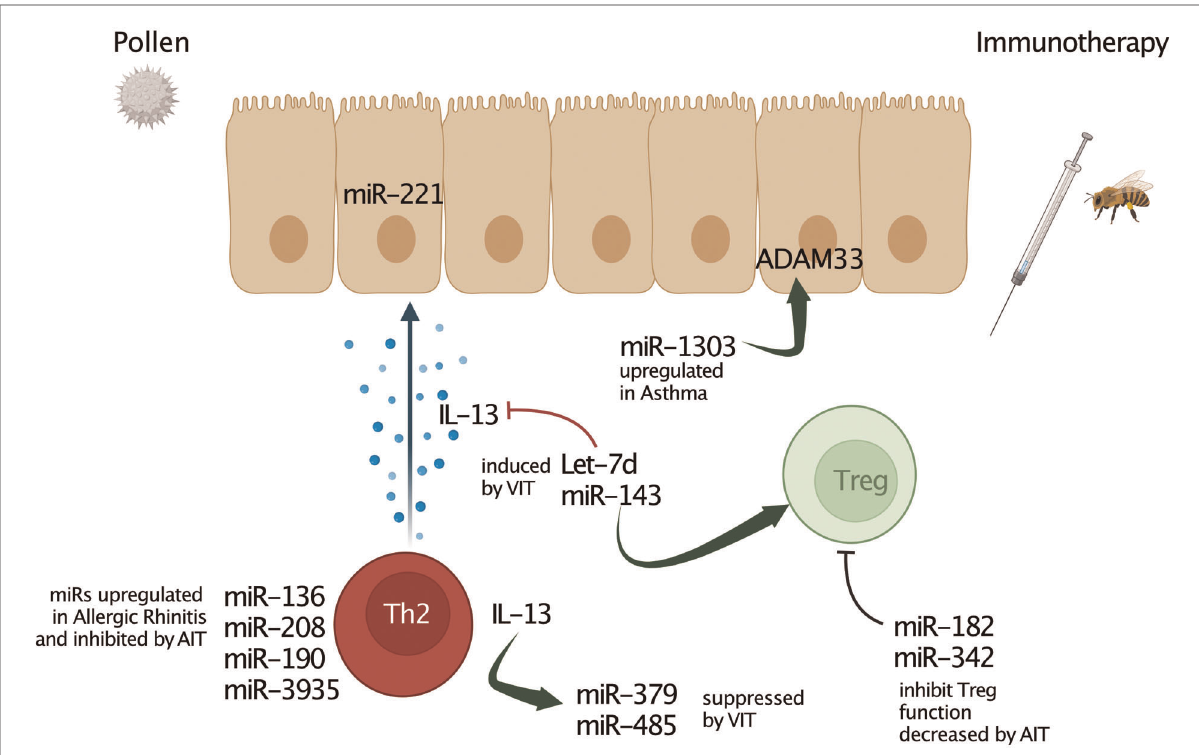
FIGURE 1 MicroRNA interactions in allergic in fl ammation and allergen-speci fi c immunotherapy (AIT). Several miRs play a crucial role in regulating multiple processes and characteristics of allergy-associated disease pathology. Deregulation of multiples miRs affects to in fl ammatory processes, Th1/Th2 response balance, cytokine, chemokine, lipid mediator production, and remodelling processes. However, miRs up-regulated by immunotherapy such as Let-7d or miR-143 can also alleviate airway in fl ammation and decrease pro-allergic cytokine production by promoting regulatory T cells (Tregs). These miRs directly inhibit type 2 key mediators such as IL-13. Further, negative regulatory association of miR-3935 and its predicted target gene, the PGE 2 receptor EP3, revealed this miR as a potential AIT-mediated mechanism in the airways of AA patients. Moreover, there is also evidence for miRs targeting regulatory factors of asthma such as